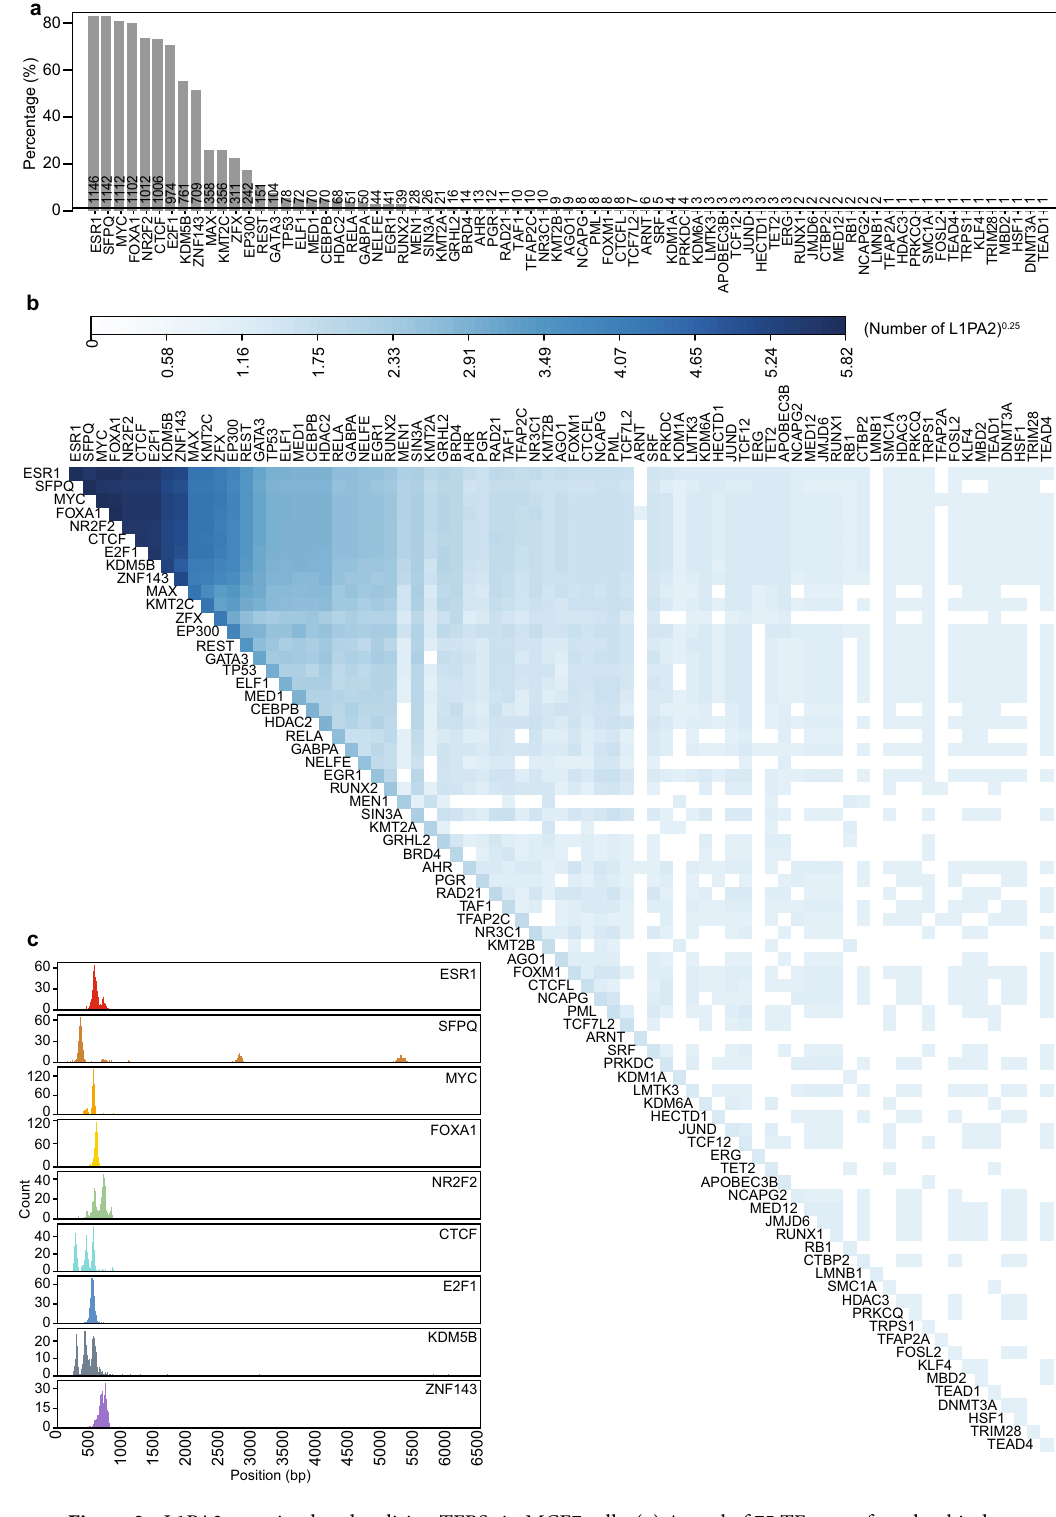
Figure 3. L1PA2 contained co-localising TFBSs in MCF7 cells. ( a ) A total of 75 TFs were found to bind to L1PA2 transposons in MCF7 cells. The bars and numbers show the percentages and counts of TF-bound L1PA2 transposons (n = 1,376) respectively. ( b ) For each pair of TFs, the number of L1PA2 transposons containing both TFBSs is shown in the heatmap, where the counts are transformed (n 0.25 ). ( c ) The majority of TFBSs co-localised to the 5 ′ UTR of L1PA2s. Histograms indicate the distribution of TFBSs for the most frequently binding TFs in the consensus L1PA2 transposon (bin = 5